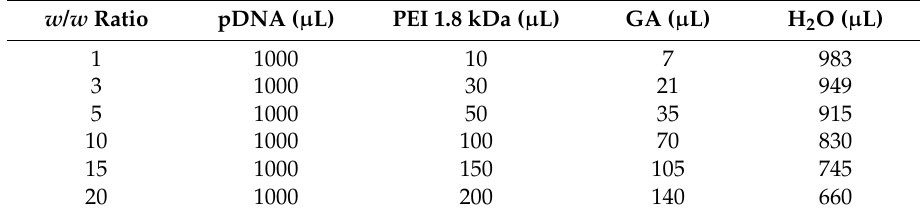
Table 1. Preparation of the GPEI polyplexes. PEI: polyethylenimine; GA: glutaraldehyde; pDNA: plasmid